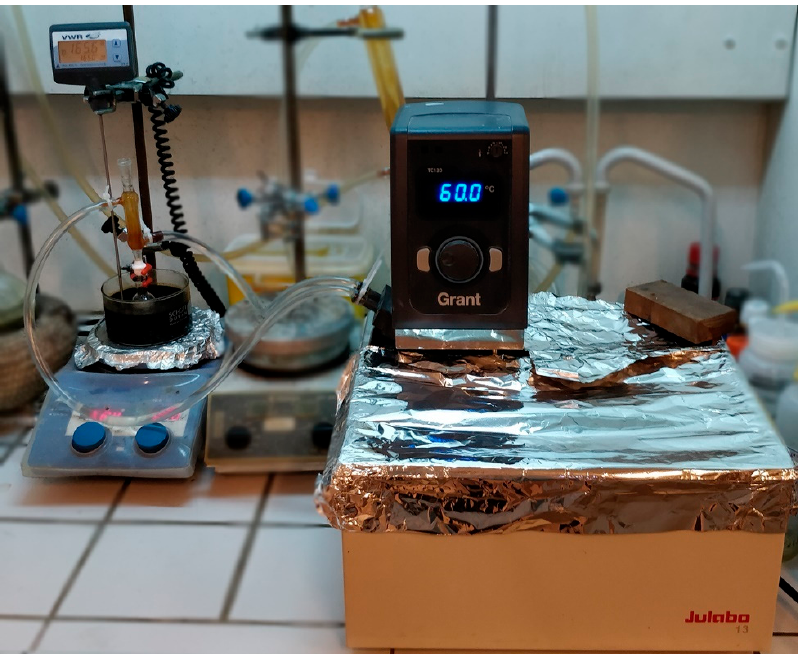
Figure A1. Experimental apparatus for circulating water in the condenser.